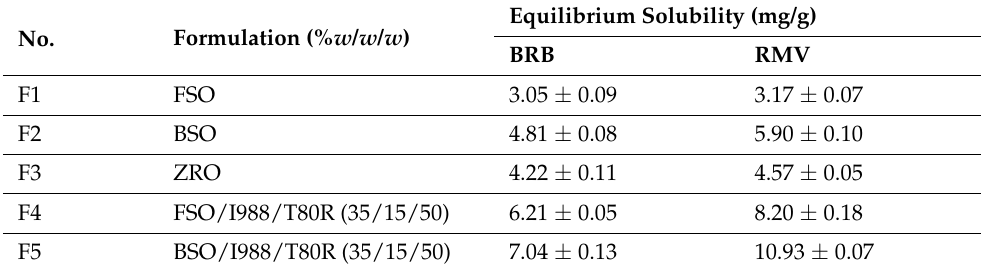
Table 6. Equilibrium solubility of BRB and RMV in lipid-based formulations. Data are expressed as mean ± SD, n = 3.